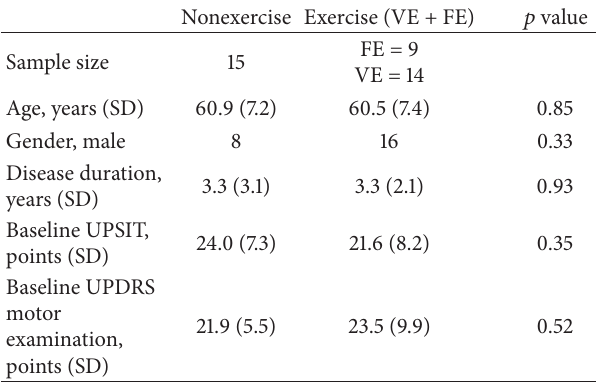
Table 1: Participant baseline demographics. Table 2: Summary statistics for change in UPSIT scores from baseline to EOT and EOT+4.